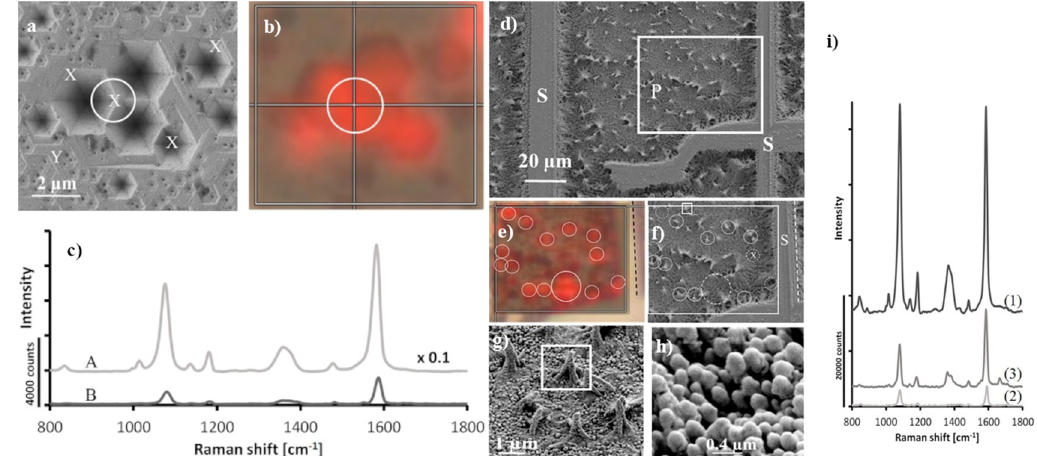
Figure 5. ( a , b ) SEM images and corresponding SERS intensity map of the spectrum of p–mercaptobenzoic acid adsorbed on the surface of GaN/AuAg (plot represents intensity of the band at 1590 cm − 1 ), ( c ) recorded SERS spectra of p–mercaptobenzoic from A: point indicated by white circle on a) and B: point indicated as Y. ( d , f – h ) SEM images of photo-etched GaN samples, ( e ) SERS intensity map of the band at 1590 cm − 1 of p–mercaptobenzoic acid and ( i ) SERS spectra of p–mercaptobenzoic acid recorded on substrates having various GAN morphologies: 1 nano-pillars, 2 on the matrix, 3 at the position matched as X in ( a ). Reprinted with permission from [37]. Copyright 2018 Elsevier.